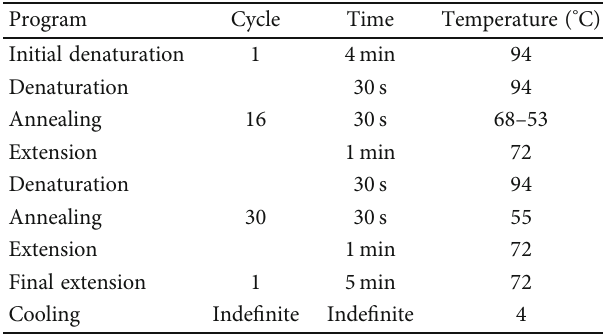
Table 2: PCR conditions for XRCC3 rs861539, XRCC4